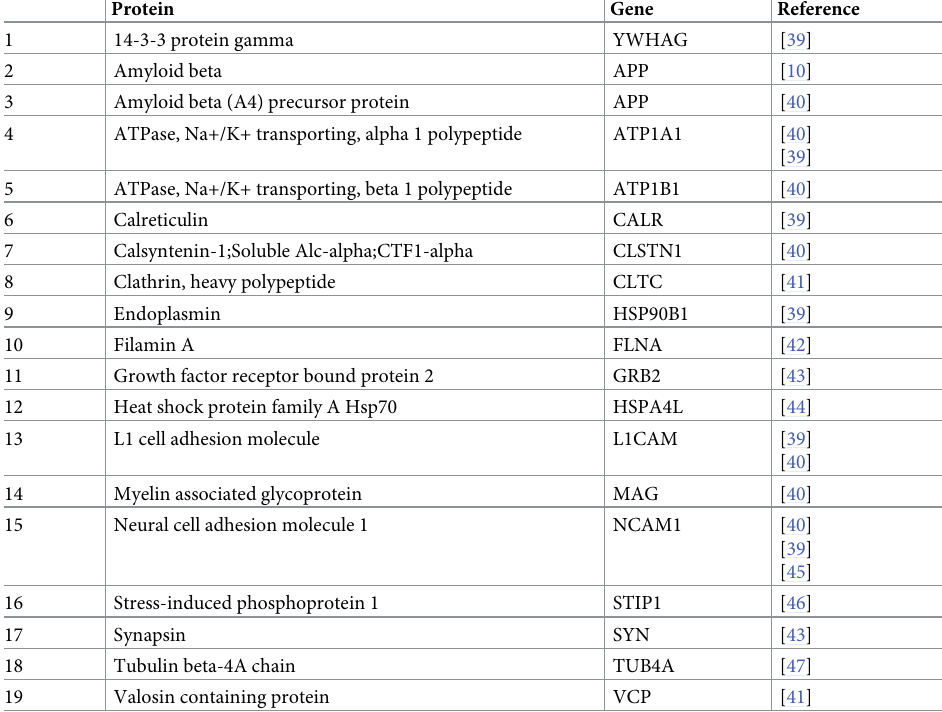
Table 2. PrP23-114-interacting proteins identified in the present study that were previously described as interac- tors of full length PrP.